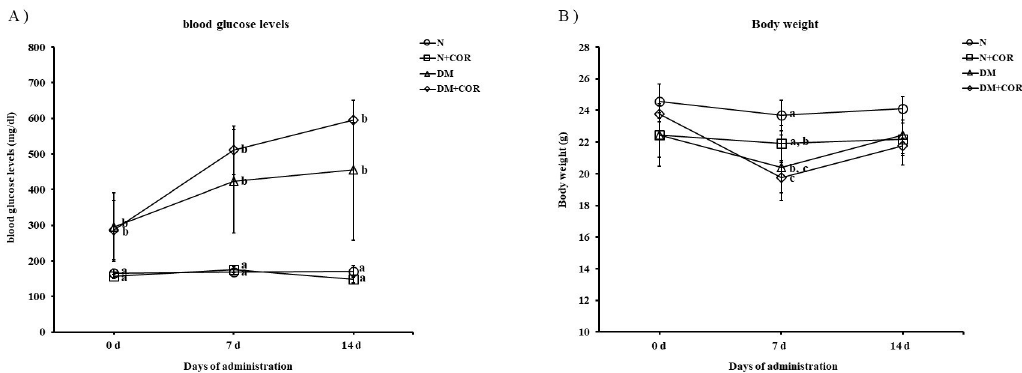
Fig 2. The effect of cordycepin on (A) blood glucose levels and (B) body weight at different time intervals of administration. Values are expressed as means ± SD. Different letters indicate statistically significant differences between groups ( P < 0.05).